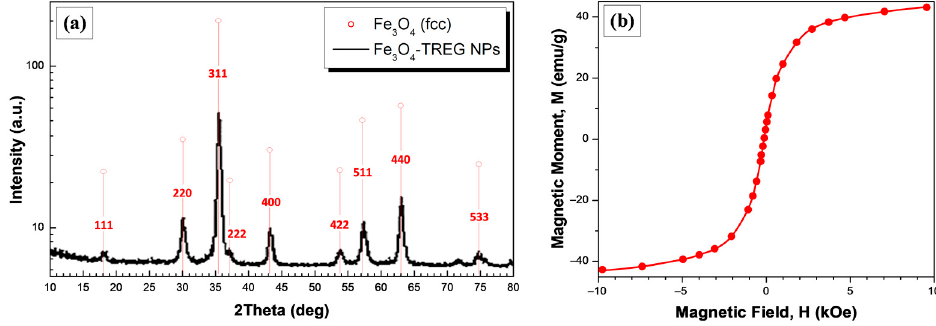
Figure 3. ( a ) X-ray diffraction patterns, and ( b ) M–H curves of the synthesized magnetite